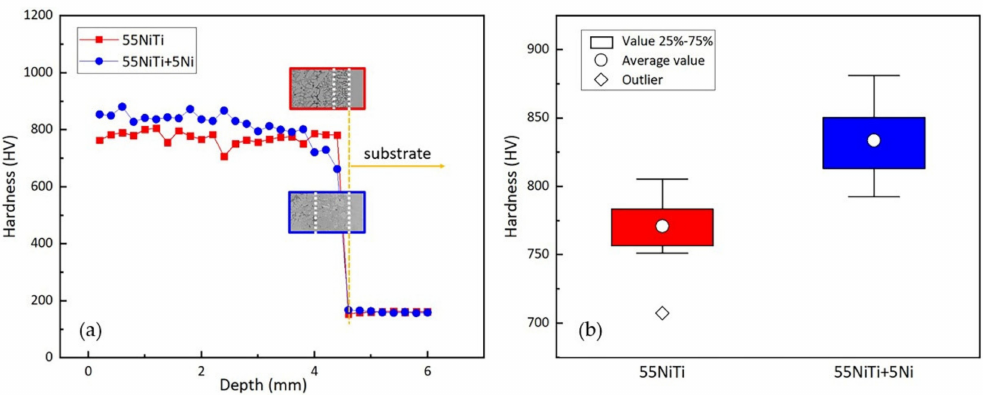
Figure 12. Microhardness results: ( a ) hardness distribution from coating surface to substrate; ( b ) boxplot of the hardness in cladding zone of the